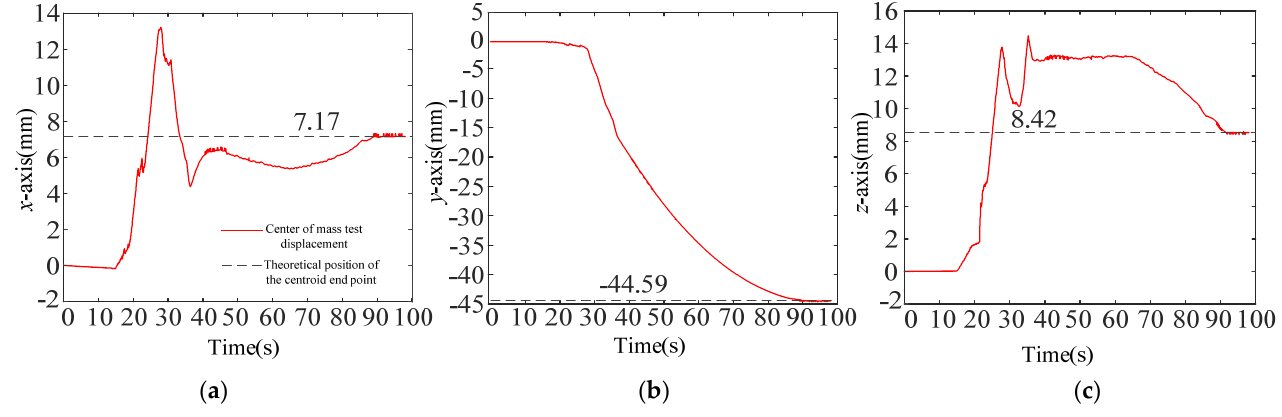
captured test payload in the third boundary pose.